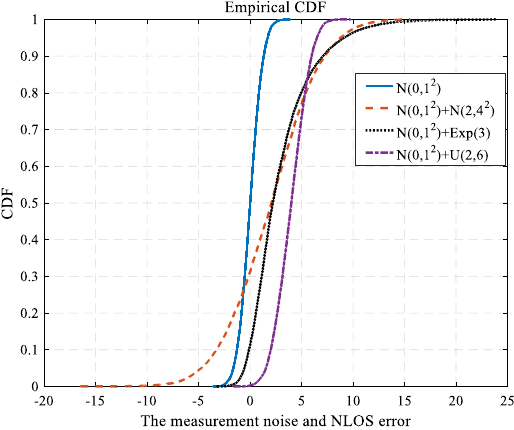
Figure 2. The CDF for measurement noise and NLOS error.